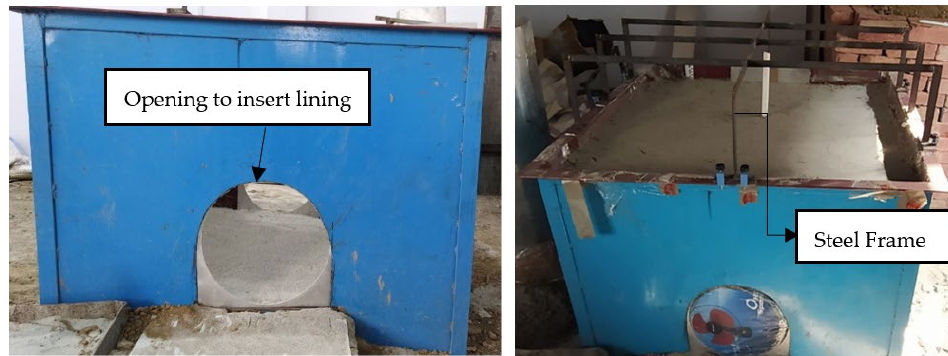
Figure 4. Establishment of lab model.